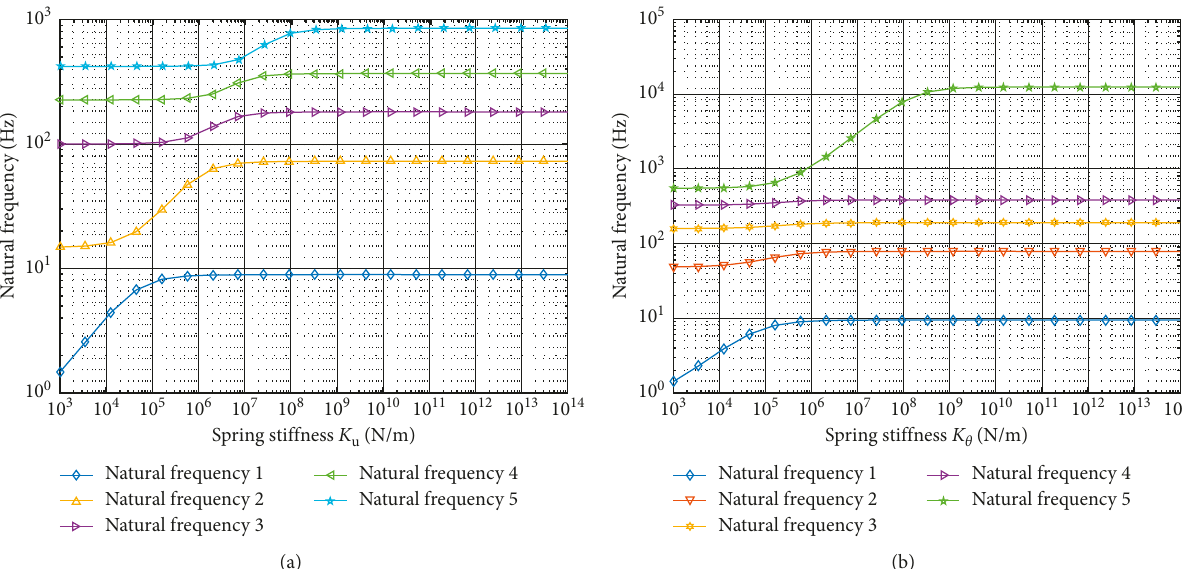
K � 8 × 10 5 Nm / rad) and (b) Δ K u ( Δ θ